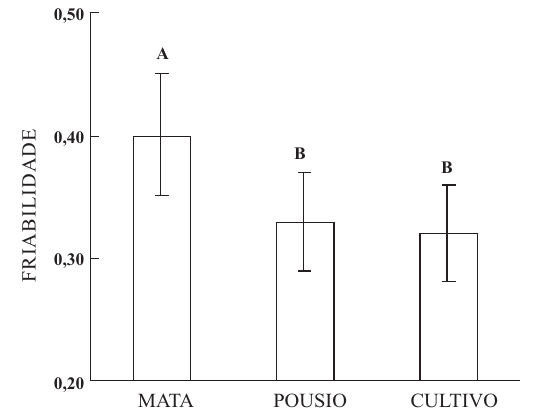
Figura 4. Valores médios de friabilidade do solo (colunas) e limites inferiores e superiores (indicados pelas barras verticais) para os tratamentos mata, pousio e cultivo. Médias seguidas de letras iguais entre os tratamentos, nas colunas, não diferem entre si pelo teste de Tukey a 5